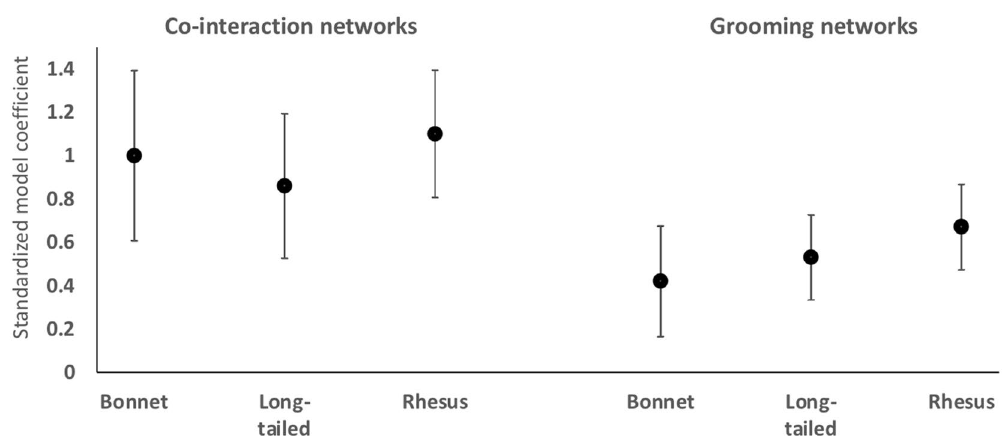
Figure 4. Plots of standardized model-coefficients (Y-axis; values from Table 2) to show the effects of the strength centrality of first-infected macaques on outbreak sizes by species, through co-interaction networks and grooming networks. Error bars represent 95% confidence intervals for each